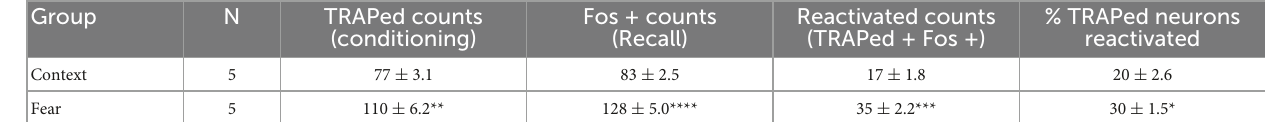
TABLE 1 Comparative size of aBLA Fos ensembles. Group N TRAPed counts